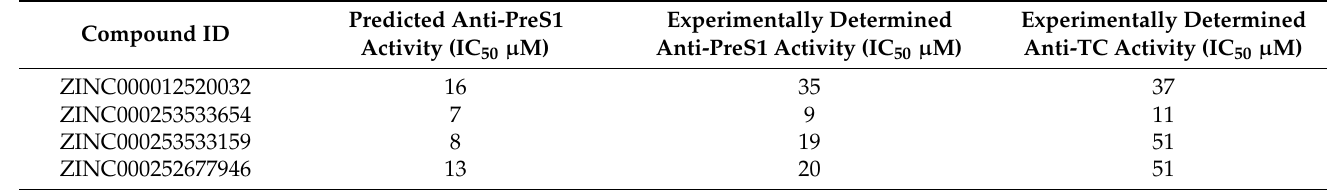
Table 6. Predictivity validation of the atom-based QSAR